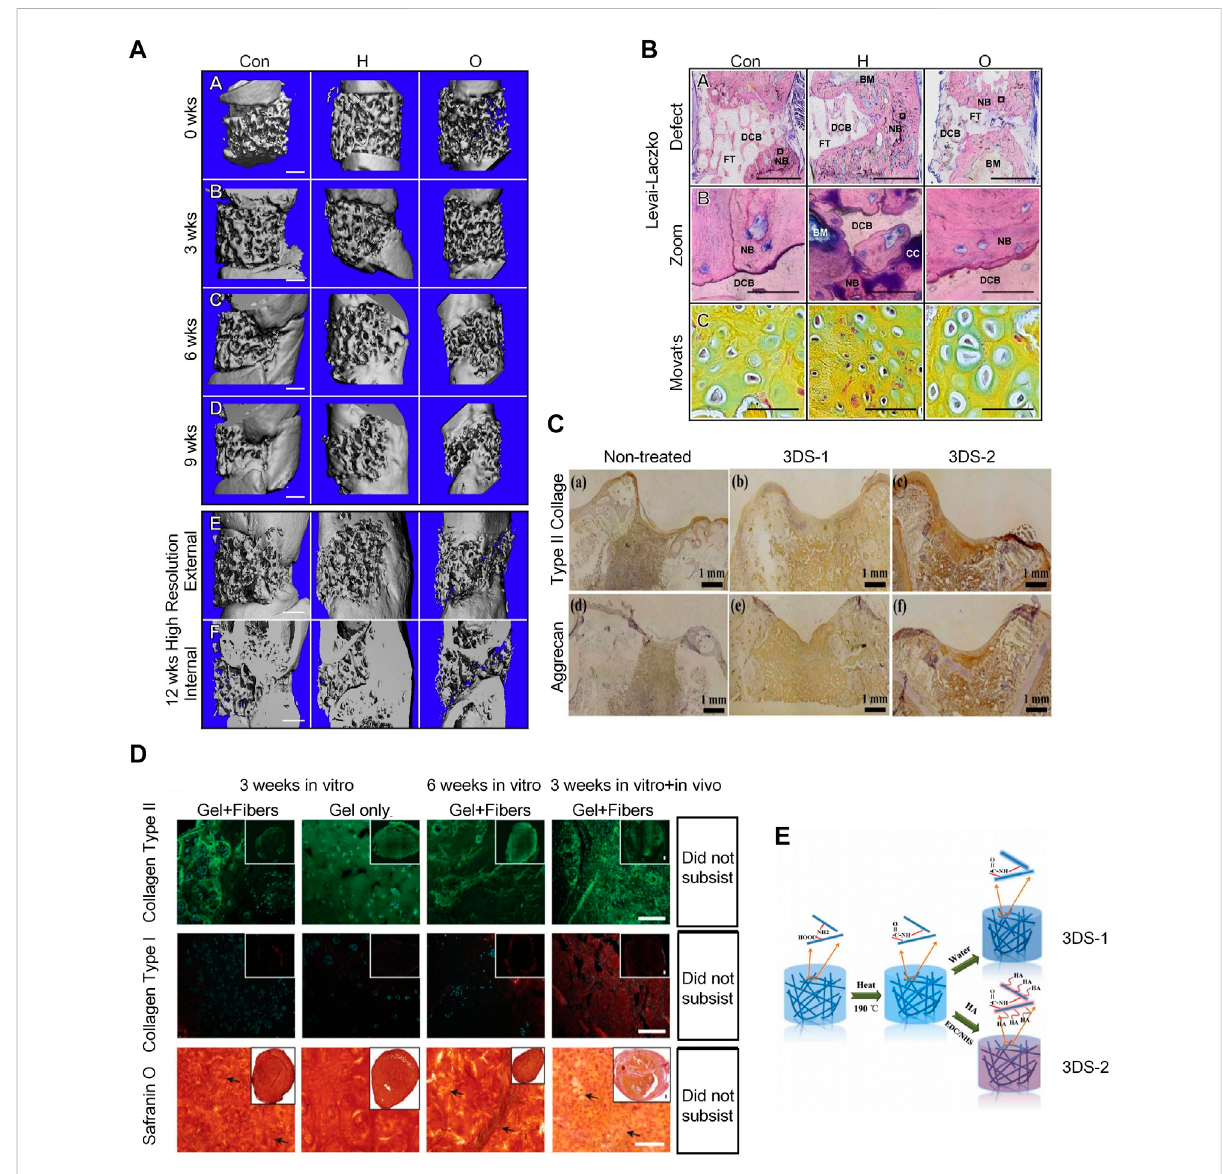
FIGURE 6 Application of dECMs and 3D Electrospun Nano fi brous Scaffolds in osteogenesis. (A) 3D μ CT reconstruction of rat femurs with decellularized scaffolds, hypertrophic chondrocyte and osteoblast grafts at 0, 3, 6, and 9 weeks post-implantation to bridge severely sized femoral defects. The inner and outer areas are shown at 12 weeks. Defect regeneration and bone formation were seen 12 weeks after implantation. (Bernhard et al., 2017)(Reprinted with permission) (B) . Histology of hard bone using Levai-Laczko staining. The magni fi ed view allows detection of calci fi ed cartilage. At the site of new bone formation, there is cartilage primordium characteristic of endochondral ossi fi cation (green staining in Movat pentachromesections)(Bernhardetal.,2017)(Reprintedwithpermission) (C) .ImmunohistochemicalstainingresultsoftypeIIcollagenandaggrecan of untreated 3DS-1 and 3DS-2 scaffolds 12 weeks after implantation in vivo . (Chen et al., 2016) (Reprinted with permission) (D) . The hydrogel/ nano fi ber composite structures exhibited better chondrogenic ECM deposition and higher stability than pure hydrogel scaffolds in in vitro cell culture and in vivo implantation. (Chen et al., 2016) (Reprinted with permission) (E) . Schematic illustration of fabrication and cross-linking of electrospun nano fi brous porous 3D scaffolds (3DS-1) and hyaluronic acid scaffolds (3DS-2) cross-linking. (Chen et al., 2016) (Reprinted with